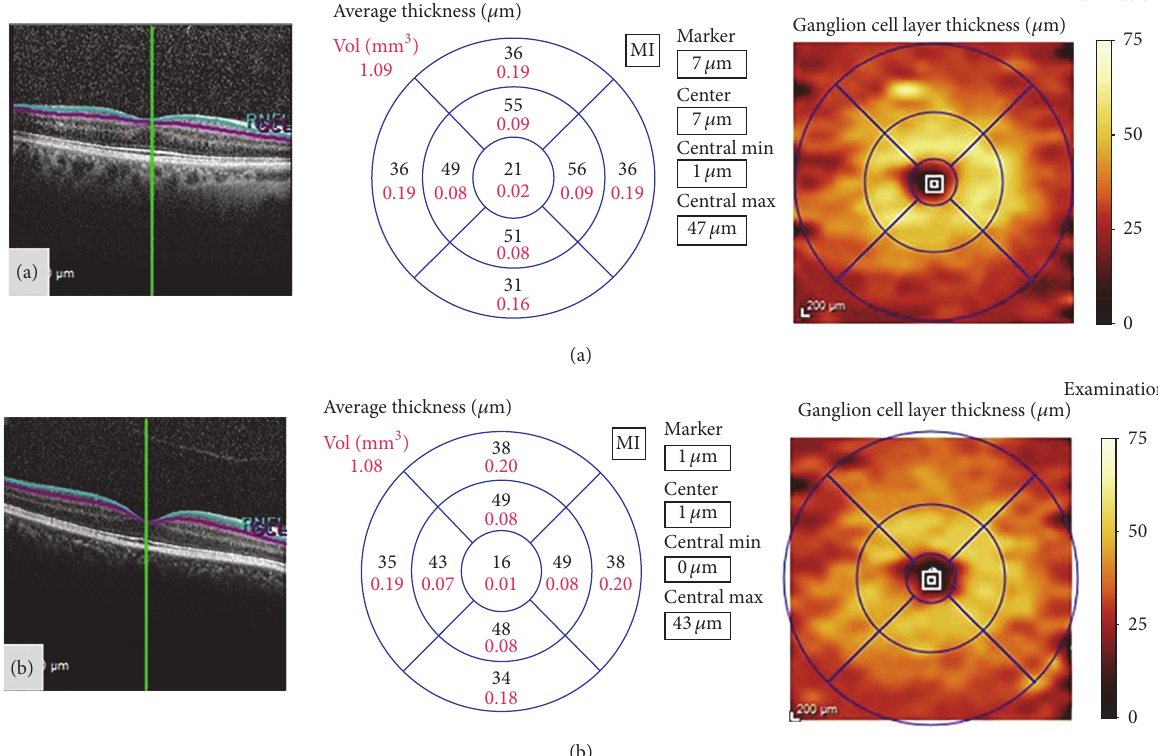
Figure 4: Example of segmentation analysis of the macular ganglion cell layer, obtained with Spectralis optical coherence tomography, in a healthy control (a) and a patient diagnosed with Parkinson disease (b). The segmentation report shows the ganglion cell layer thickness (in microns) and total volume (in mm 3 ) of the ETDRS macular area. In this patient (b), the central and inner macular areas present thinning of the ganglion cell layer, compared with the healthy control